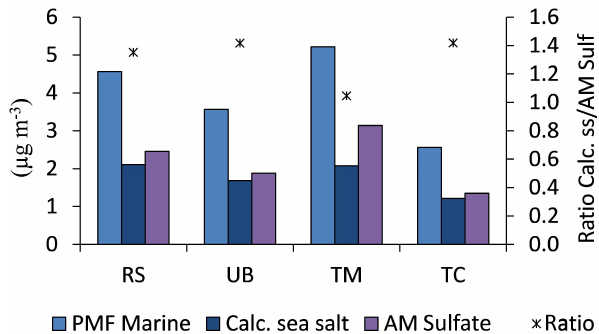
Figure 8. Average sources contributing to the sea salt factor during SAPUSS at the four monitoring sites RS, UB, TM and TC. Calcu- lated sea salt contributes on average 1.8µgm − 3 and marine sulfate from regional pollution 2.2µgm − 3 . (AM: anthropogenic marine).